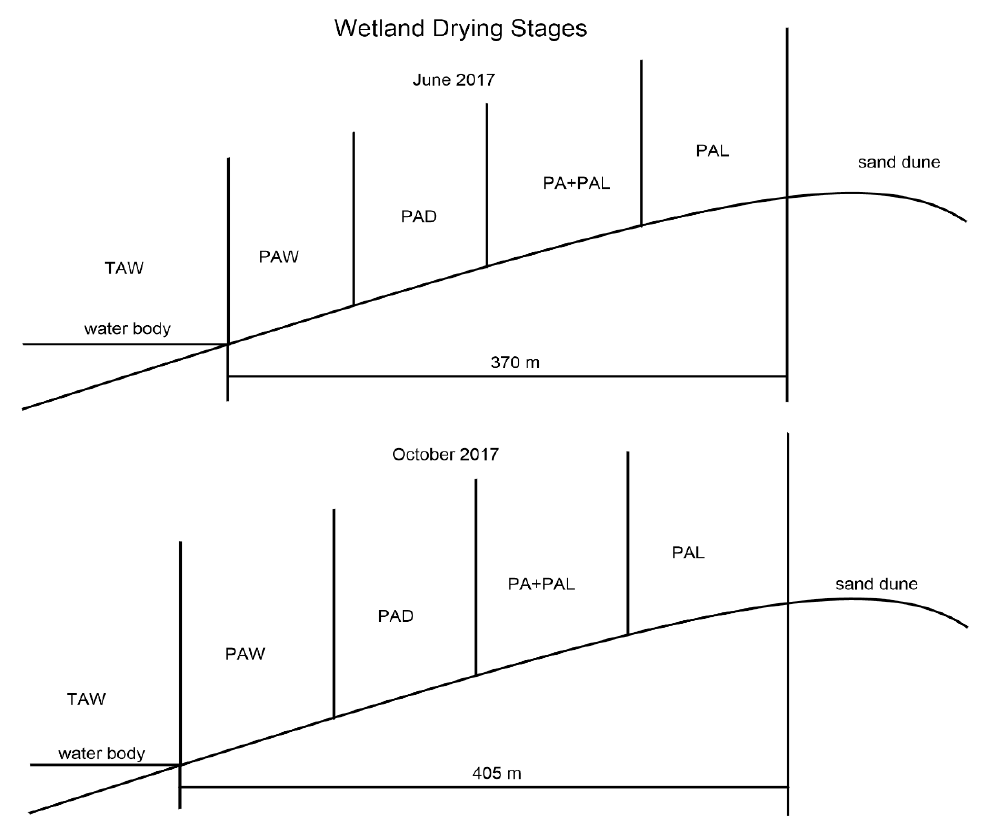
Figure 1. Different stages in wetland drying process. TAW, T. augustifolia wetland; PAW, P. australis wetland; PAD, P. australis dry land; PA + PAL, mixed grassland with P. australis and P. arundinacea L.; PAL, P. arundinacea L. grassland.